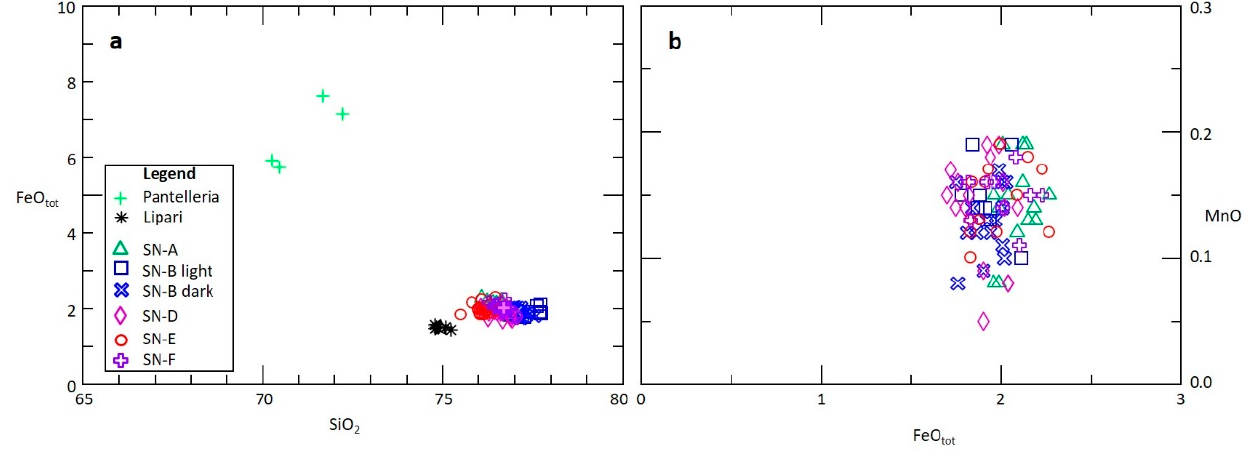
Figure 9. ( a ) FeO tot vs. silica diagram for Sierra de las Navajas (this work), Pantelleria (data from [31]), and Lipari (data from [30]) obsidians; ( b ) MnO vs. FeO tot diagram. The effect of other transition elements on colors is difficult to evaluate with available EMPA data, as both chromium and nickel are below or very close to the detection limit. Manganese can reduce the green color arising from iron because it oxidizes Fe 2+ into Fe 3+ [29]. In Figure 9b, where Manganese content is plotted versus total iron, it is evident that no relation exists between the two elements in the obsidians of Sierra de las